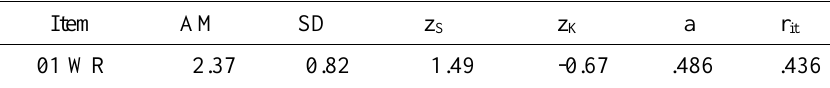
Descriptive statistics, factor loadings and corrected item-test correlations of WAESTA items (WR = worry, AV = avoidance, EM = emotionality): Results from the construction